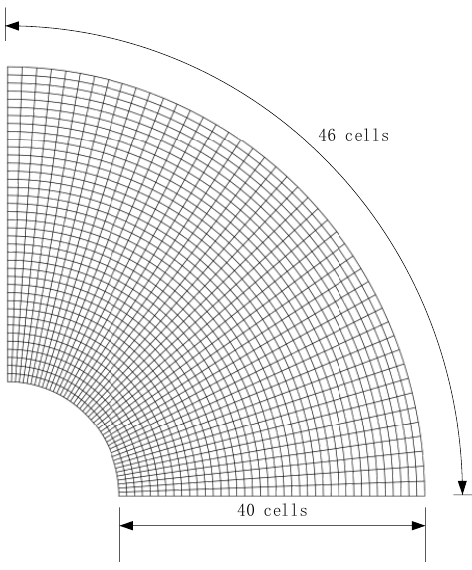
Figure 8. The design domain of the rotor.